Question: Looking at the figure, what chart type is it?
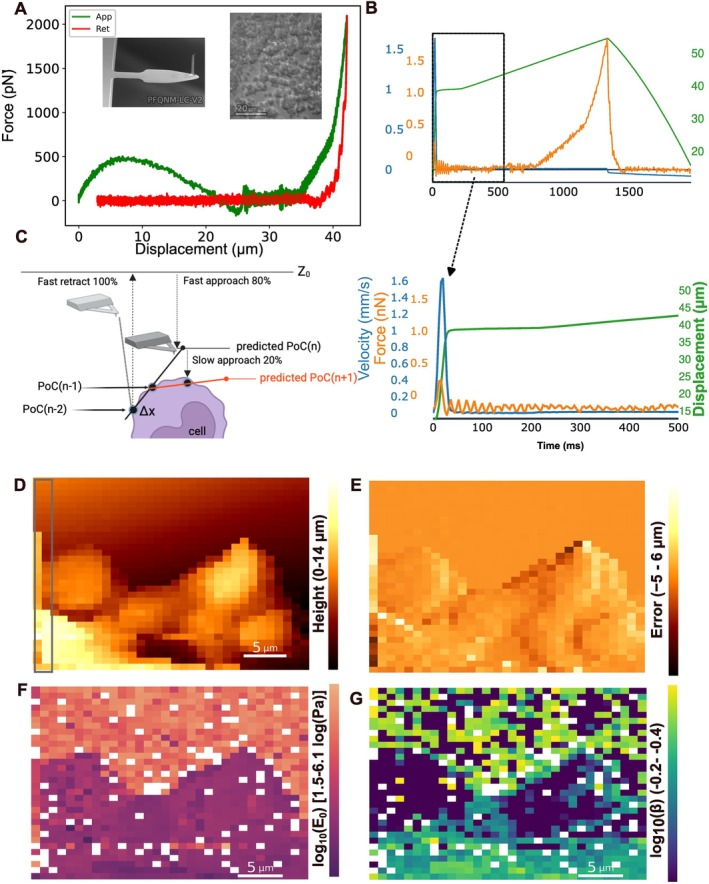
Answer: line